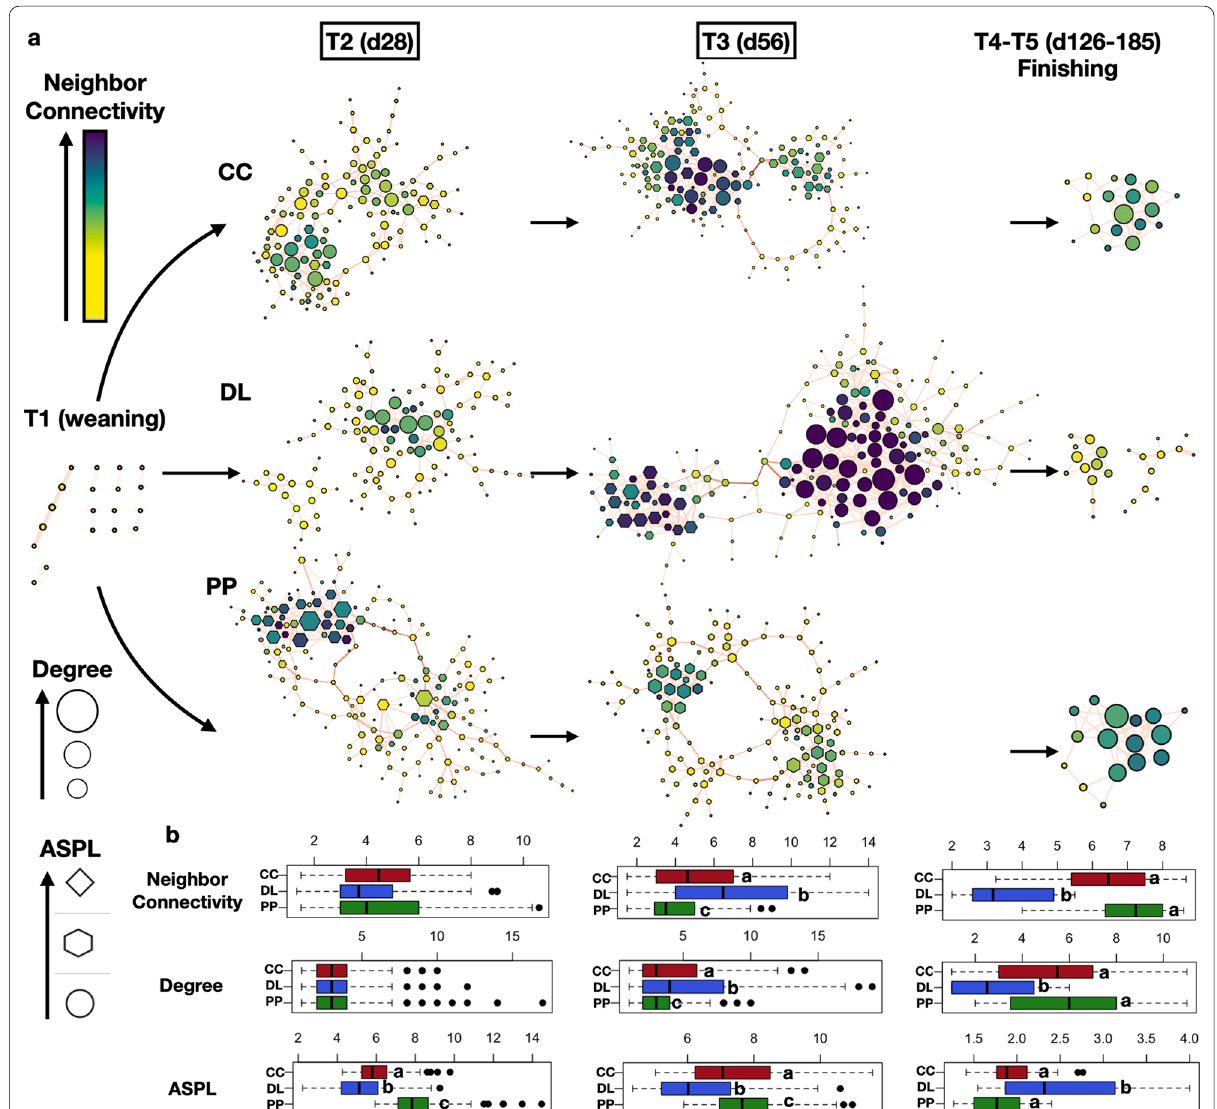
attributes in the rumen microbiome of calves at weaning, BKG and finishing can be visualized. Nodes represent a given ASV and edges show the association (correlation) between two given bacterial taxa (nodes). Color key represents neighbor connectivity, which measures the average connectivity of all surrounding nodes in the network. Size of node represents the average degree of connectivity or number associations a given node has in the network. Shape represents the average shortest path length, a measure of how fast information can travel through a network. Differences in the variation of all these network attributes between each group at BKG and finishing can be observed in the box plots depicted in panel ( b ), where letters represent significant differences based on Wilcoxon Rank Sum tests (P < 0.05). Dry lot (DL); cover crop (CC) and